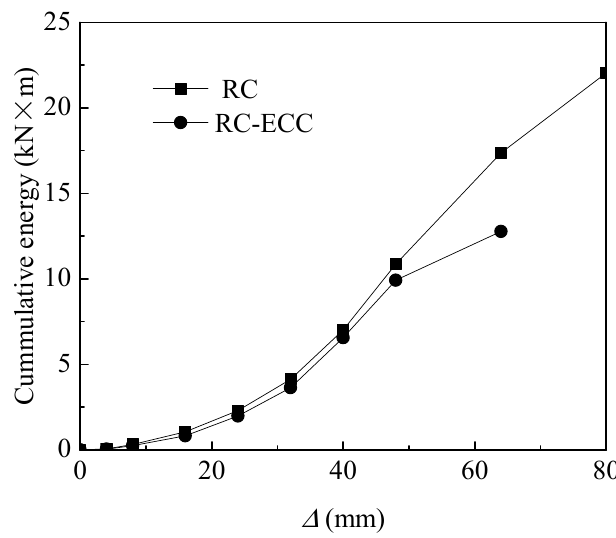
Figure 9. Comparison of cumulative dissipated energy between RC and RC-ECC composite columns.